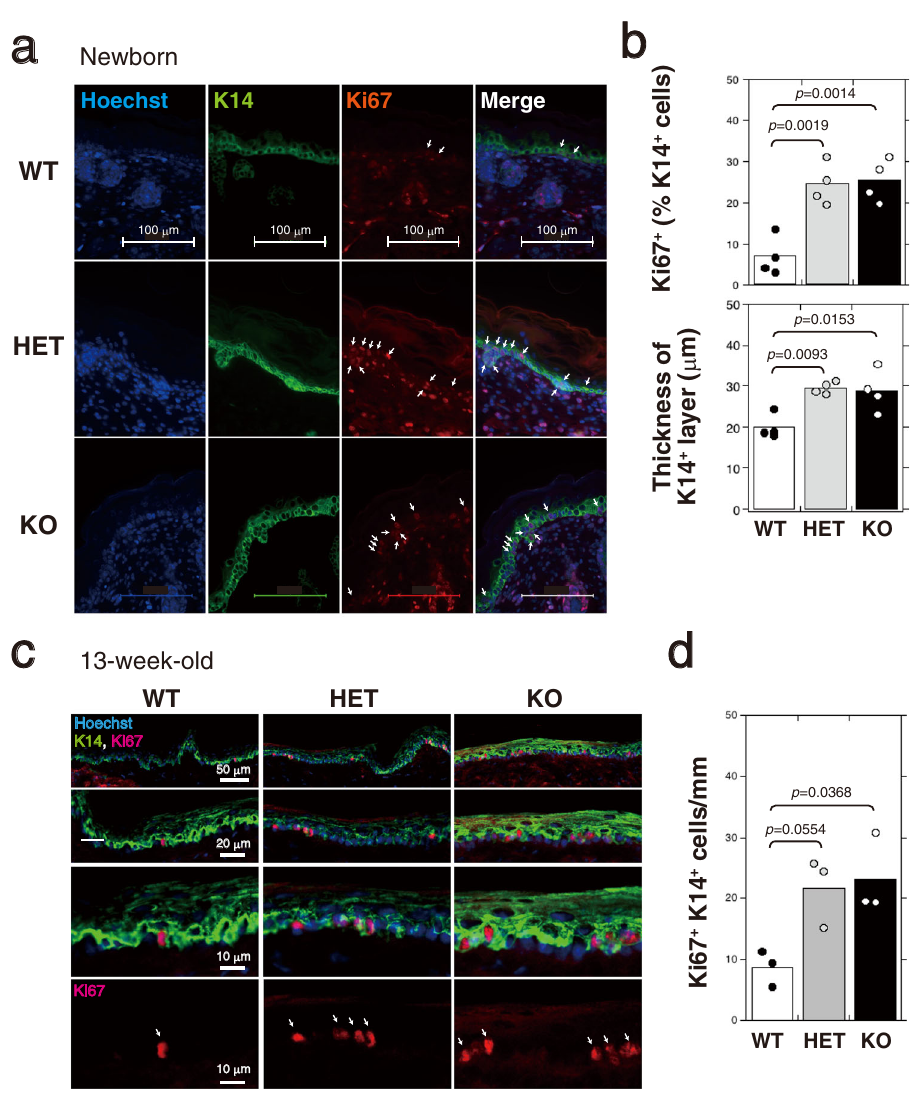
Fig. 2 Proliferation of keratinocytes is accelerated by downregulation of CS-C. a Immuno fl uorescence labeling of skin from newborn C6st-1 WT, C6st-1 HE, and C6st-1 KO mice was performed using anti-K14 and anti-Ki67 antibodies. Nuclei are counterstained with Hoechst33342. b Quanti fi cation of Ki67- positive cells in K14-positive basal layers, and measurement of epidermal thickness in K14-positive basal layer of C6st-1 WT ( n = 4), C6st-1 HE ( n = 4), and C6st-1 KO mice ( n = 4). Multiple random vertical lines perpendicular to the epidermal border were measured. From the mean thickness of these lines, epidermal thickness in K14-positive basal layer was calculated. c Immuno fl uorescence labeling of tail skin from 13-week-old C6st-1 WT, C6st-1 HE, and C6st- 1 KO mice was performed using anti-K14 and anti-Ki67 antibodies. Nuclei are counterstained with Hoechst33342. d Numbers of Ki67-positive cells within 1 mm of K14-positive basal layers in C6st-1 WT ( n = 3), C6st-1 HE ( n = 3), and C6st-1 KO mice ( n = 3). The number of Ki67-positive cells per mm of basal layer length was counted manually using a digital imaging software (Photoshop CS6). Statistical signi fi cance was determined using one-way ANOVA with Tukey ’ s HSD